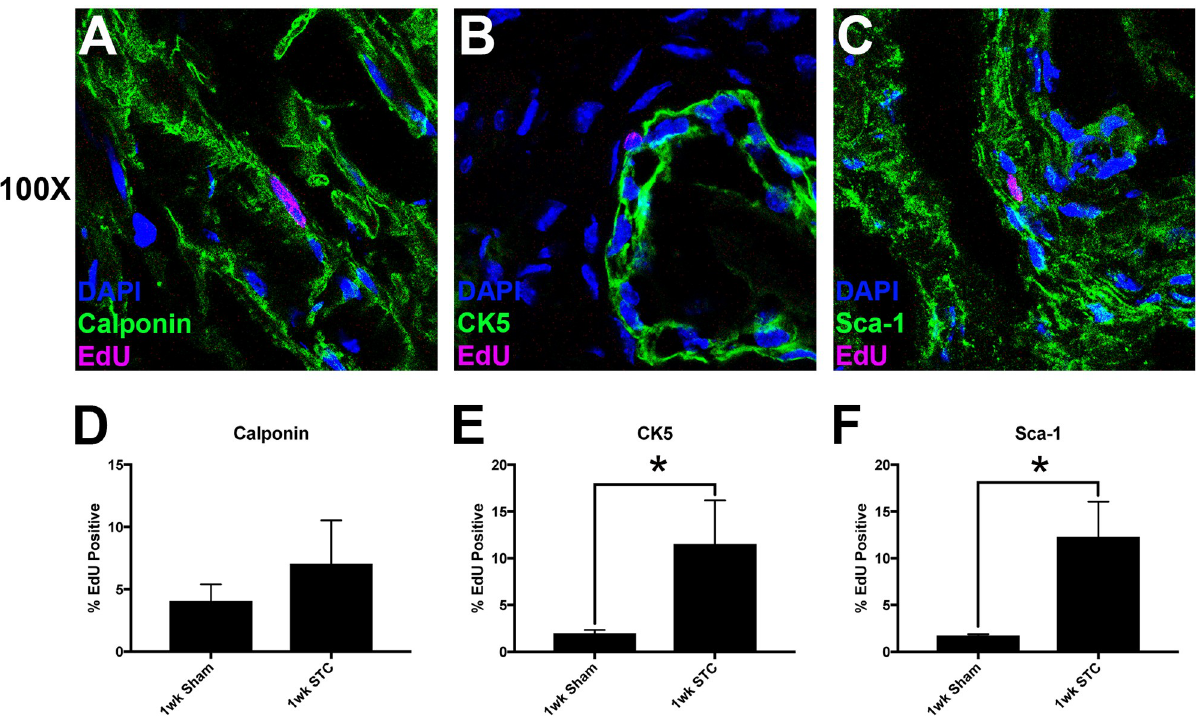
Fig 7. Quantification of EdU incorporation in smooth muscle, urothelial and BMSCs. (A-C) Representative confocal images of EdU treated STC bladders stained with anti-calponin (A), anti-CK5 (B) and anti-Sca-1 (C) all in green. All nuclei are stained with DAPI (blue) and EdU incorporation is shown in pink. Quantification of co-localization of EdU + nuclei with antibody stain. This is indicated on the y-axis as %EdU incorporated. The number shown is the mean number of %EdU + /antibody + cells divided by the total number of antibody + cells x100 per section counted. Significance ( � ) is indicated above bars (P < 0.05). Error bars are standard error of the